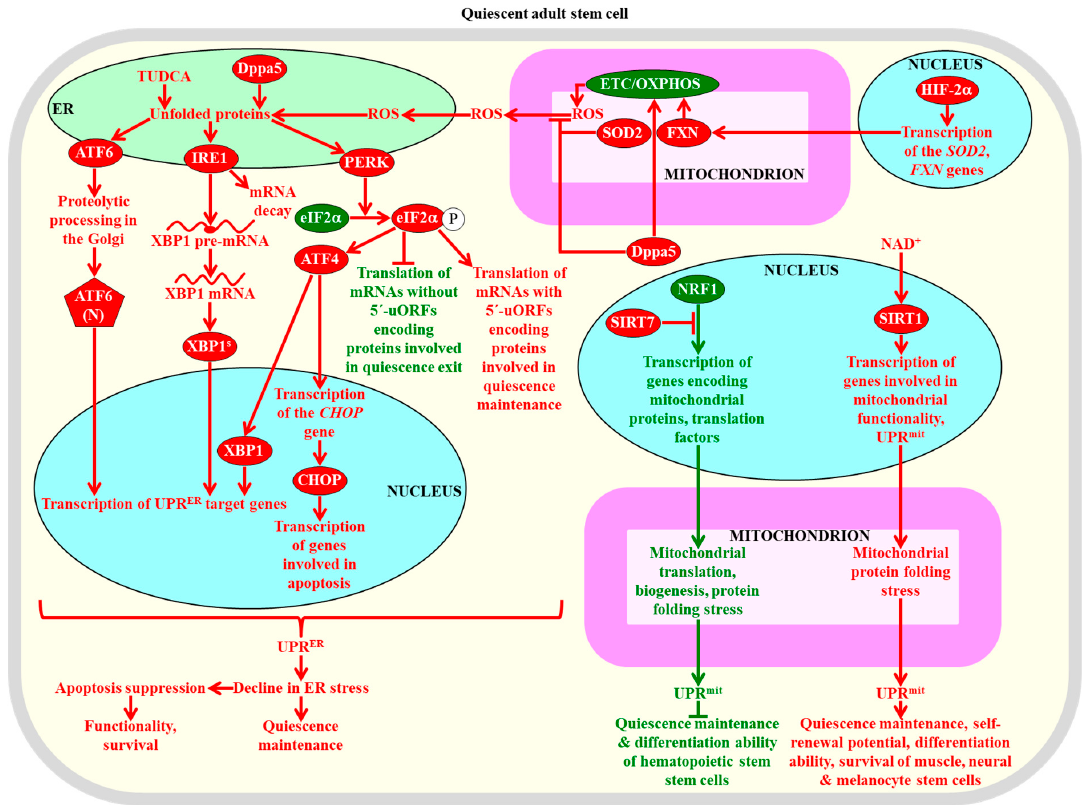
Figure 6. The unfolded protein response (UPR ER ) and (UPR mit ) systems of proteostasis restoration in adult stem cells are required for the maintenance of their quiescence, self-renewal proficiency, proliferation potential, differentiation competence, functionality, and viability. A stimulation of the ATF6 (activating transcription factor 6), IRE1 (inositol requiring enzyme 1), and PERK (PKR-like endoplasmic reticulum kinase) branches of the UPR ER system is essential for the maintenance, self-renewal, functionality, and survival of adult stem cells. A SIRT7-dependent inhibition of the UPR mit system is indispensable for sustaining the quiescence and differentiation capability of hematopoietic stem cells. A NAD + /SIRT1-dependent stimulation of the UPR mit system is required for the maintenance of the quiescence, self-renewal potential, differentiation ability, and viability of muscle stem cells, neural stem cells, and melanocyte stem cells. Proteins, metabolites, and processes whose activities, concentrations, and rates must be increased to maintain the quiescence of adult stem cells are displayed in red. Proteins, metabolites, and processes whose activities, concentrations, and rates need to be increased to promote the exit of adult stem cells from the state of quiescence are displayed in green. See text for more details. Abbreviations: ATF4, activating transcription factor 4; ATF6(N), N-terminal cytosolic fragment; CHOP, C/EBP homologous protein; Dppa5, developmental pluripotency-associated 5 protein; eIF2 α , eukaryotic translation initiation factor 2 α ; ER, the endoplasmic reticulum; ETC, electron transport chain; FXN, frataxin; HIF-2 α , hypoxia-inducible factor 2 α ; NRF1, nuclear respiratory factor 1; OXPHOS, oxidative phosphorylation; ROS, reactive oxygen species; SIRT1 and SIRT7, sirtuin 1 and sirtuin 7 (respectively); SOD2, mitochondrial manganese superoxide dismutase; TUDCA, tauroursodeoxycholic acid; uORFs, upstream open reading frames; XBP1, X-box binding protein 1; XBP1 s , X-box binding protein 1 translated as a protein product the spliced mRNA for XBP1.